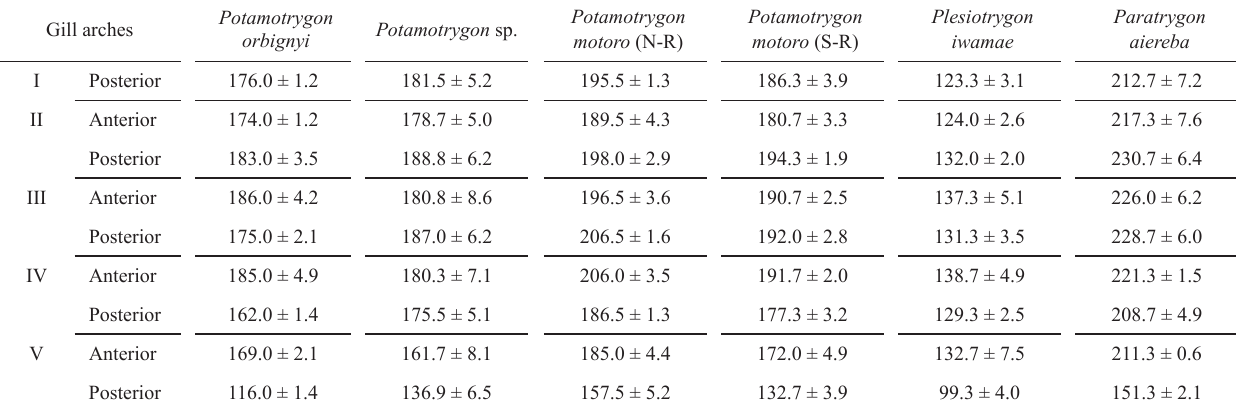
Potamotrygon Potamotrygon Plesiotrygon Paratrygon motoro (N-R) motoro (S-R) iwamae